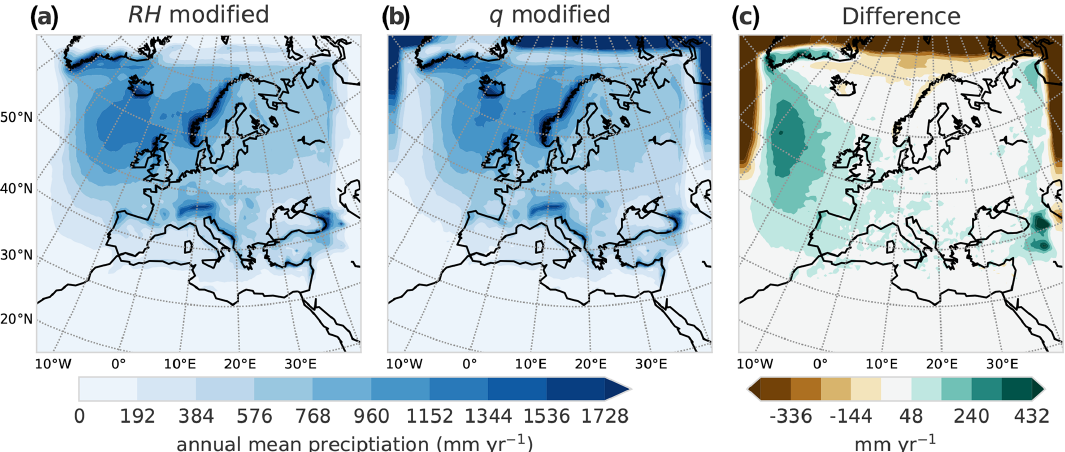
Figure 11. Different modifications of humidity in PGW simulations and their effect on annual mean precipitation between 2070 and 2099. (a) Humidity is changed according to the GCM-projected changes in relative humidity. (b) Humidity is changed according to projected changes in specific humidity. (c) Difference between panels (a) and (b) . The panels show the whole computational domain, including the lateral relaxation boundary zone. Details on the models used are given in Table A1.